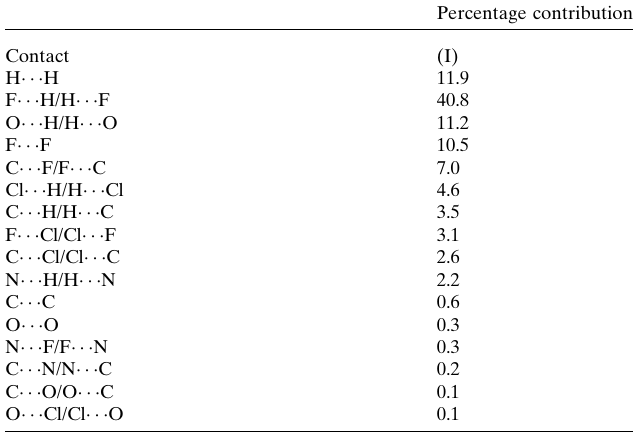
Table 3 Percentage contributions of interatomic contacts to the Hirshfeld surface for (I).